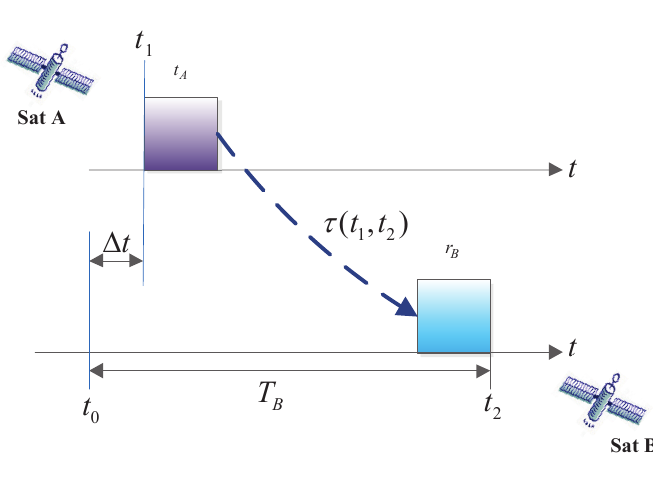
Figure 1. One-way pseudo-range measurement process.